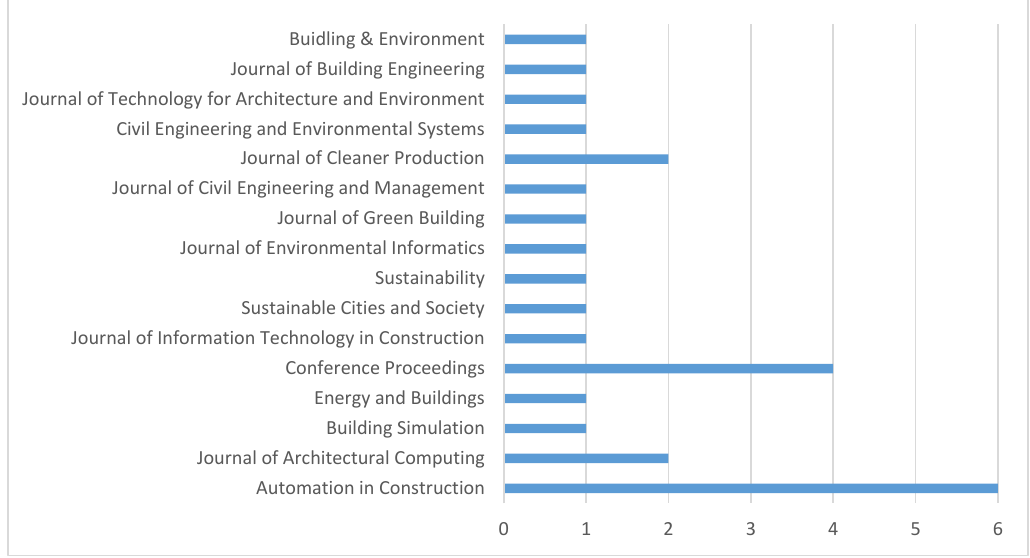
Figure 9. Preferred journals (BREEAM, LEED and SBTool).